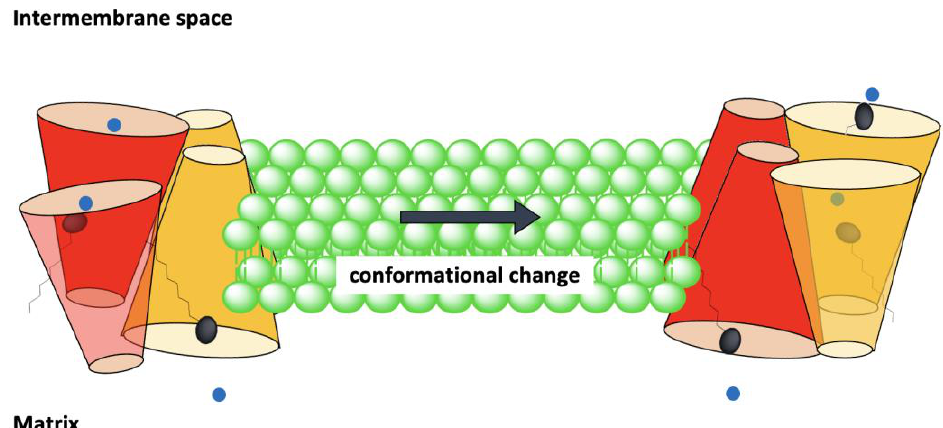
Figure 6. The Biphasic Two-State model for proton transport and inhibition of tetrameric UCP2. The monomeric subunits within a dimeric unit are functional and conformationally correlated. Initially the first dimeric pair (red) is in the cytoplasmic state (open to the IMS) where the fatty acid and proton can be absorbed. Upon movement of the protonated head group of the fatty acid from the IMS to the matrix, the red dimeric pair’s conformation changes to the matrix state (open towards the matrix). The second dimeric pair (yellow), which was initially in the matrix state, transforms to the cytoplasmic state in parallel to the movement of fatty acid’s head group towards the IMS. The four subunits of the tetramer do not have identical conformations at any time; however, the monomers within one dimeric unit are always at comparable conformational states (compare the red subunits conformation with yellow). Deprotonated fatty acids are shown in black, and protons are shown as blue spheres. Fatty acids are protonated at the IMS and deprotonated in the matrix. Changes in conformation of one dimeric pair can induce conformational changes in the other dimeric pair.